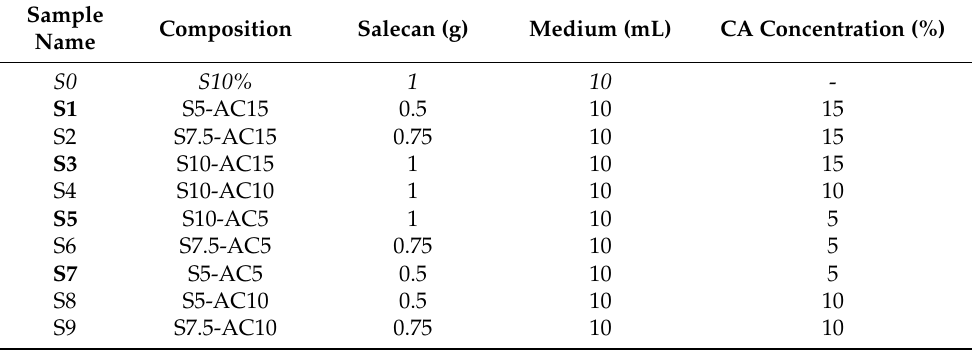
Table 1. Samples annotations and feed compositions of the synthesized salecan